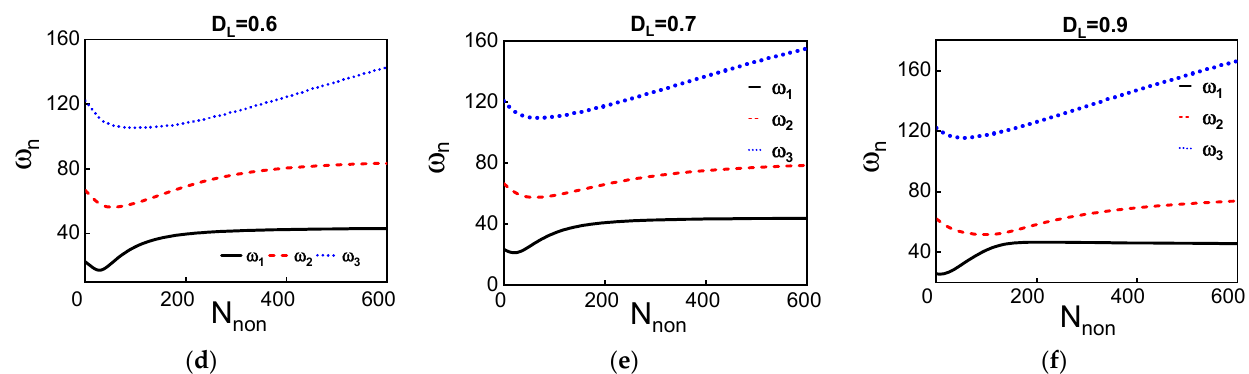
Figure A1. ( a – f ): The variation of the three lowest natural frequencies with axial load for different dome lengths. The initial rise of the dome is equal to 1 μ m.